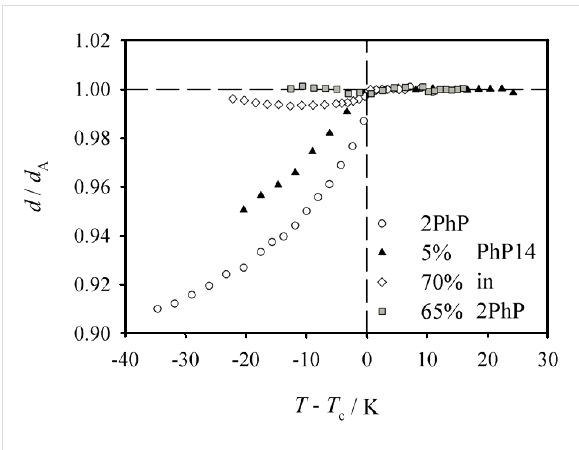
Figure 5: Reduced layer spacing for the mixtures which exhibit SmA and SmC phases in the system 2PhP / PhP14 . Pure 2PhP shows quite normal layer shrinkage of 7% at T − T c = −20 K (open circles). The addi- tion of 5% of PhP14 reduces the layer shrinkage to only 5% at T − T c = −20 K (filled triangles). For the mixtures with excess of the long homo- logue PhP14 the layer shrinkage is dramatically reduced. The 70%- mixture exhibits a layer shrinkage of only 1% at T − T c = −20 K and for the mixture with 65% no layer shrinkage below the SmA to SmC phase transition could be observed at all.